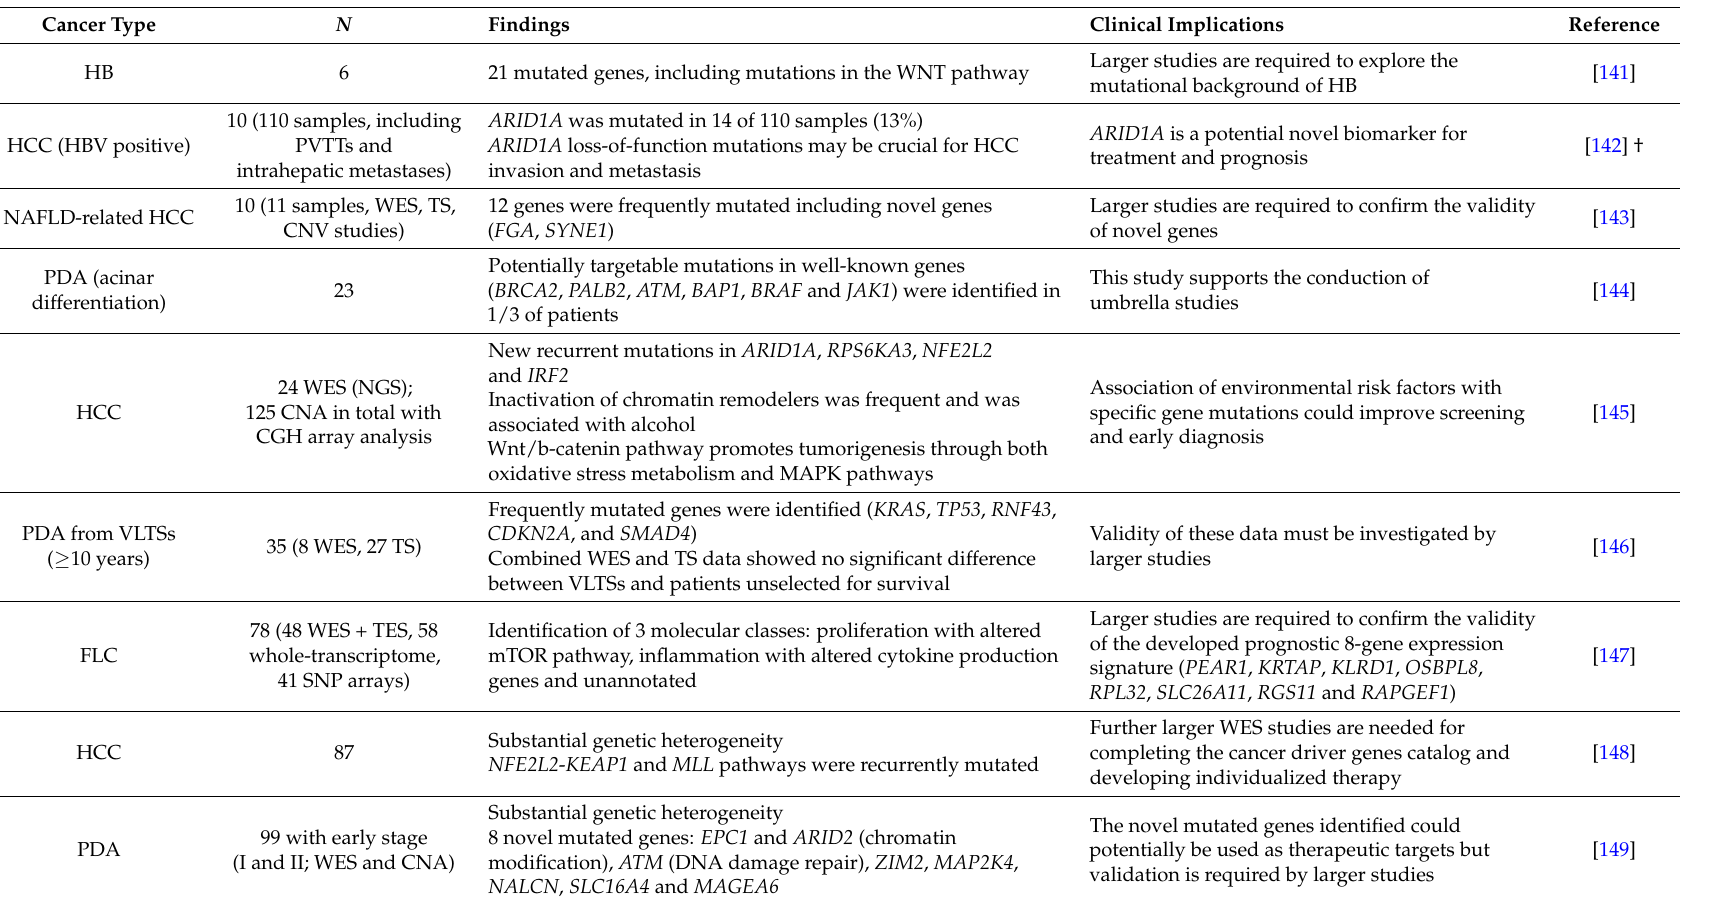
Table 8. Whole-exome sequencing studies on hepatobiliary and pancreatic